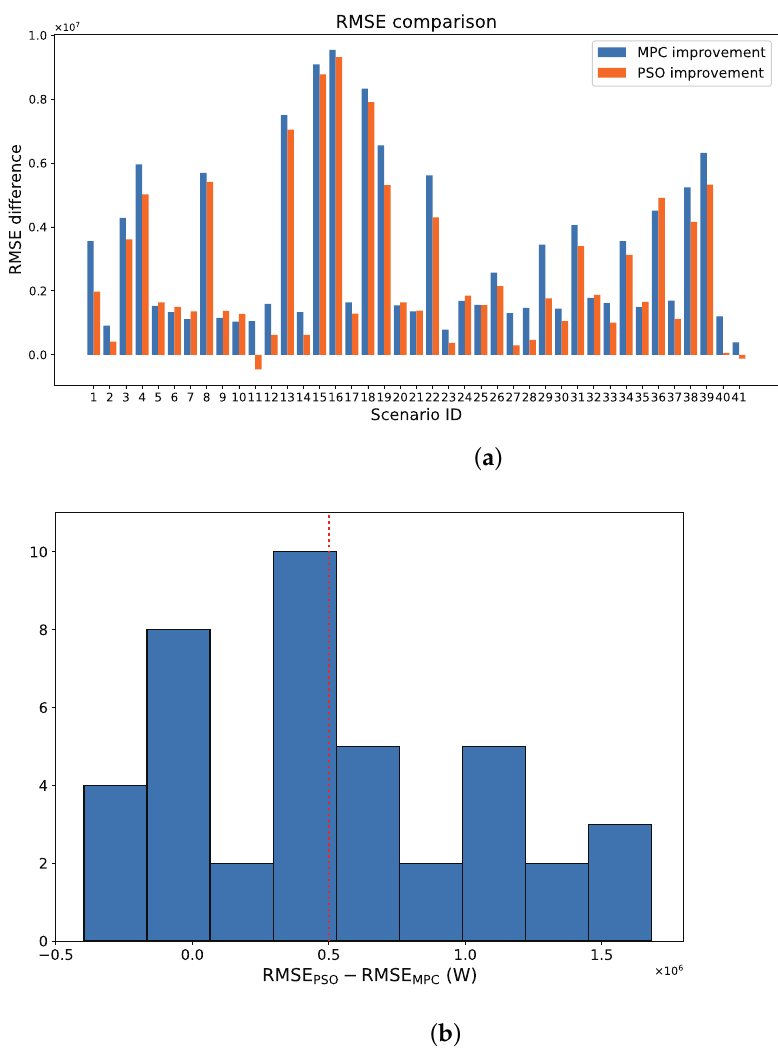
Figure 13. ( a ) The total flux RMSE differences comparison of the two aiming strategy related to the static strategy. ( b ) The histogram indicates the distribution of the RMSE differences between the two optimized aiming strategies. The red dashed line represents the mean value indicating the average improvement of the MPC-based aiming